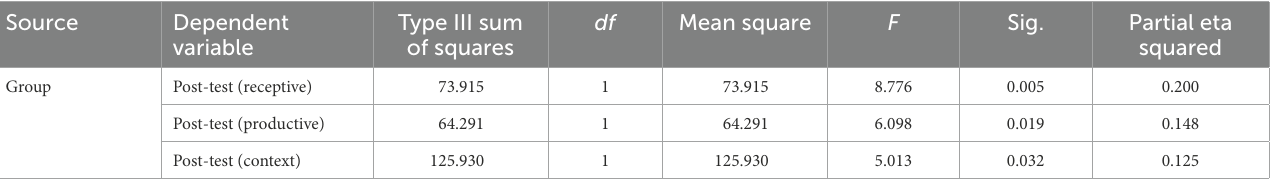
TABLE 4 Tests of between-subjects effects for the scores obtained on post-tests.